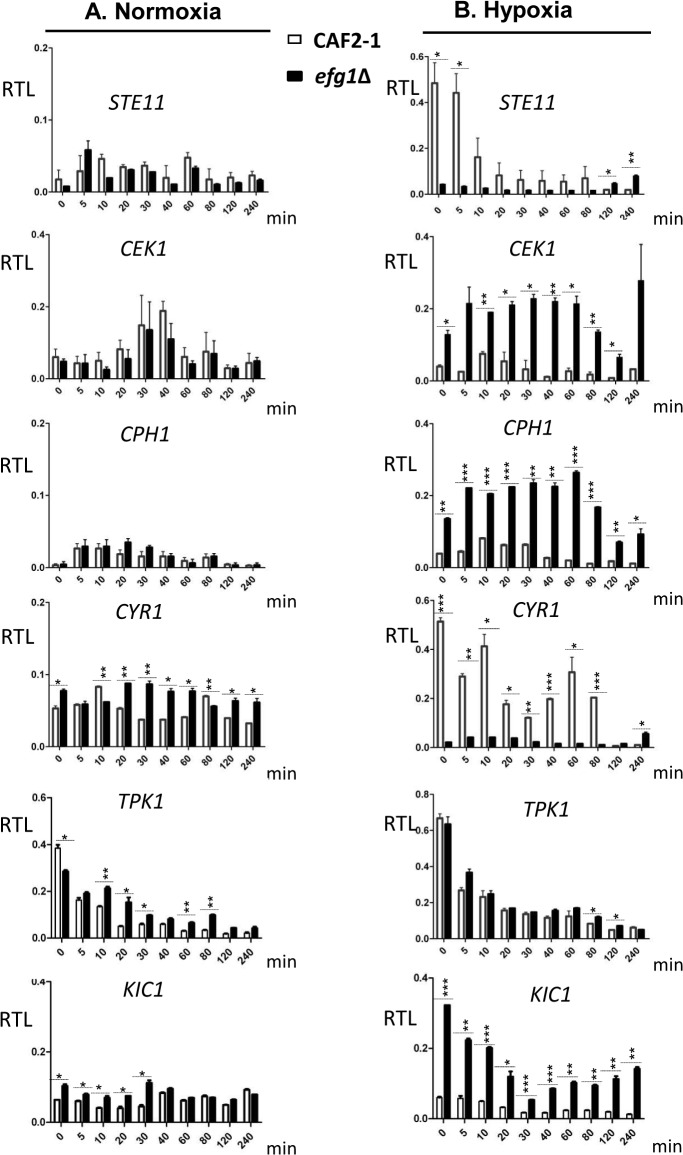
Transcriptional regulation of Efg1 target genes under normoxia and hypoxia.Strains were precultured under normoxia at 30°C in YPD medium and used for inoculation of 200 ml YPD cultures for normoxia, or under 0.2% O2 for hypoxia. Cultures were incubated at 30°C under normoxia or hypoxia, and at the indicated times 20 ml of culture was withdrawn and used for preparation of total RNA. At each time point, two biological replicates and three technical replicates were assayed by qPCR using gene-specific primers. mRNA levels are expressed as means ± SEM of transcript levels relative to the ACT1 transcript (RTL), for normoxia (A) and hypoxia (B) grown cultures. A two-tailed, unpaired t test comparing the RTL values of control strain CAF2-1 and efg1 mutant HLC52 was used to determine the statistical relevance. *, P < 0.05; **, P < 0.01; ***, P < 0.001.